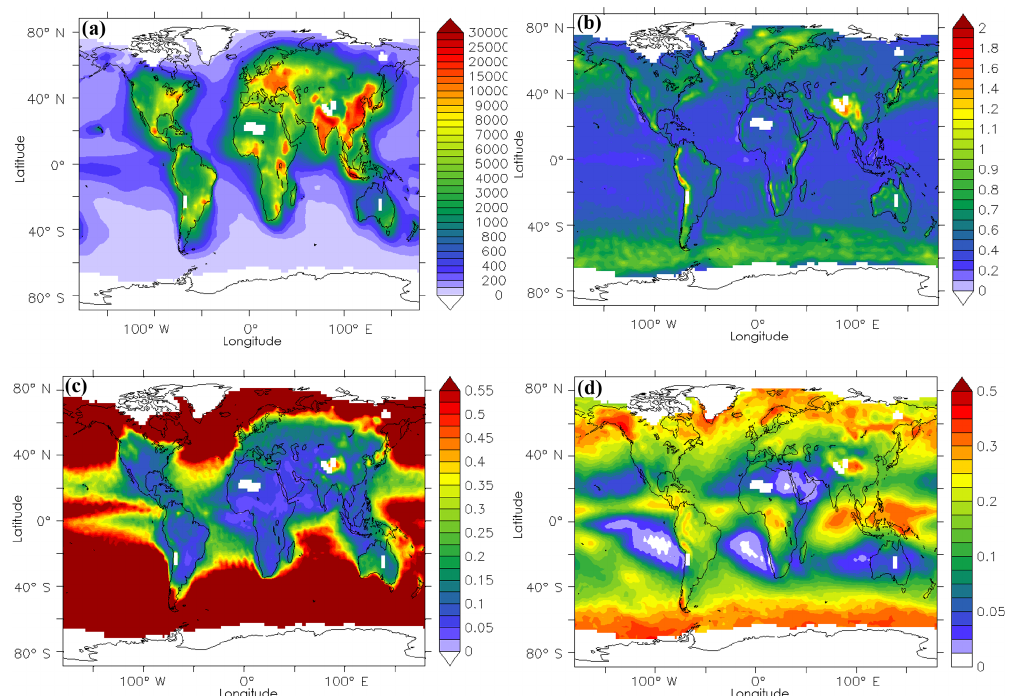
Figure 2. Predicted in-cloud annual mean (a) aerosol number concentration (cm − 3 ) , (b) updraft velocity (ms − 1 ) , (c) maximum supersat- uration (%) at the lowest cloud-forming level (940hPa), and (d) predicted annual mean low-level cloud cover. White areas correspond to regions where liquid cloud droplets do not form.